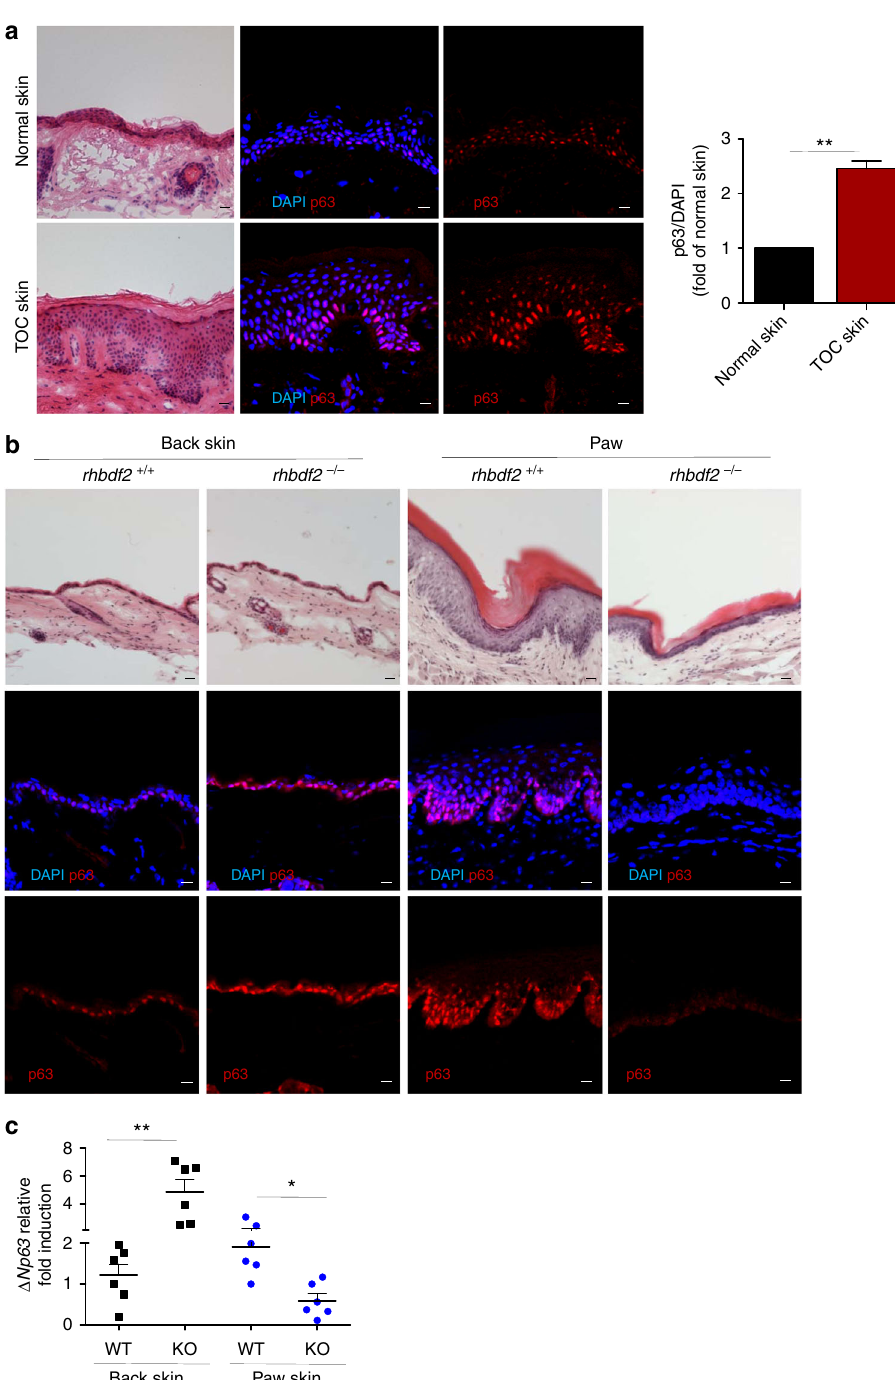
Fig. 2 Distinct regulation of p63 in normal and hyperproliferative keratinocytes. a Representative images of H&E stained sections, displaying a hyperproliferative epidermis in TOC compared to normal interfollicular skin. Confocal microscopy analysis shows p63 ( α -pan p63) expression in TOC and in control interfollicular skin. DAPI (blue) is used as a nuclear stain. Scale bars: 20 µ m. Graph represents quanti fi cations of p63 expression in ratio with the nuclei from three human samples. Student ’ s two-tailed t -test value is shown, ** p < 0.01. b Representative H&E stained back skin and fore-paw sections from 20-week-old rhbdf2 + / + and rhbdf2 − / − mice. Scale bar: 20 μ m. Confocal analysis of p63 ( α -pan p63) expression was performed in back skin and fore- paw sections of rhbdf2 + / + and rhbdf2 − / − mice. Scale bar: 20 µ m. c qRT-PCR for Δ Np63 from mRNA extracted from back skin and fore-paws of rhbdf2 + / + and rhbdf2 − / − mice. The graph shows n = 6 of each genotype. The statistical analysis was performed using Student ’ s two-tailed t -test (* p < 0.05, ** p <